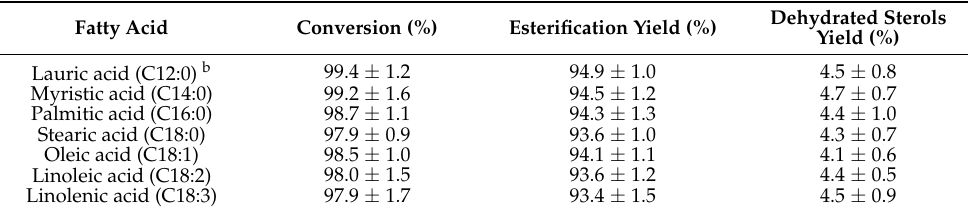
Table 2. Effect of different fatty acids on esterification a .